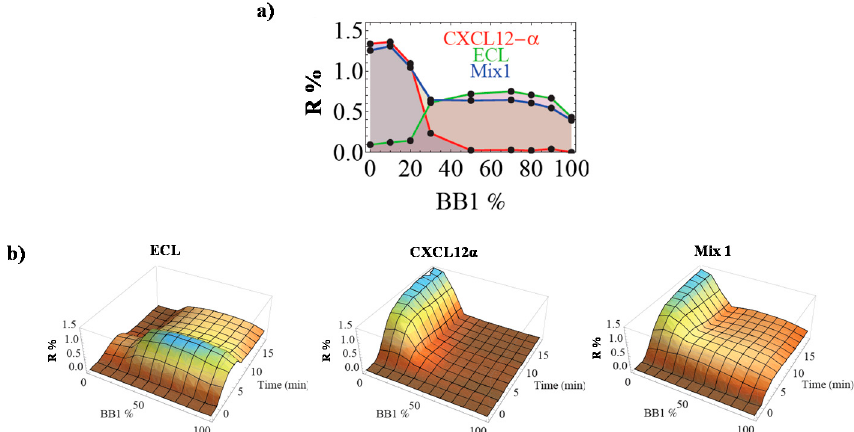
Figure 5. Analysis of simple protein mixtures by the eT. ( a ) CEPs of Mix1 (ECL + CXCL12 α ) compared to the ones of pure Erythrina cristagalli lectin (ECL) and CXCL12 α ; ( b ) CELs of ECL, CXCL12 α , and their mixture Mix1. Adapted from [26].